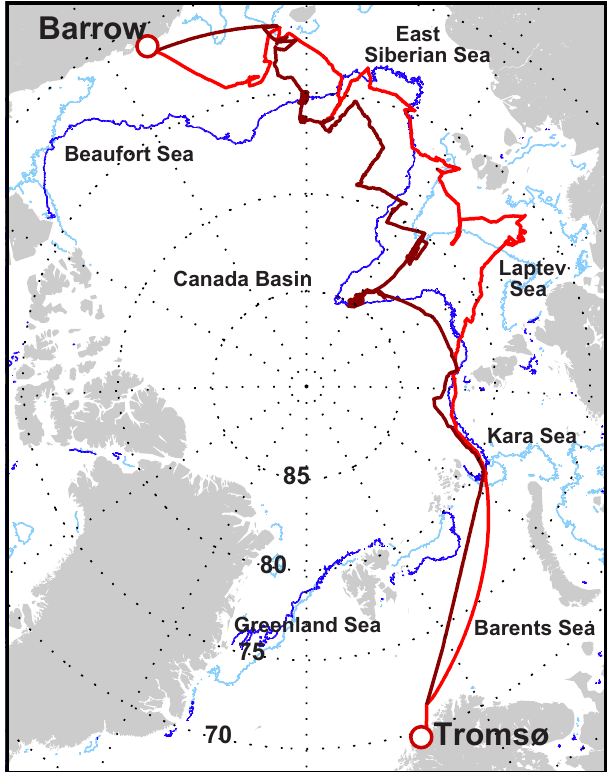
Figure 1. Cruise track of the legs from Tromsø to Barrow (red) and back (brown). Ice edges at the times of start and end of the cruise are shown in light and dark blue,